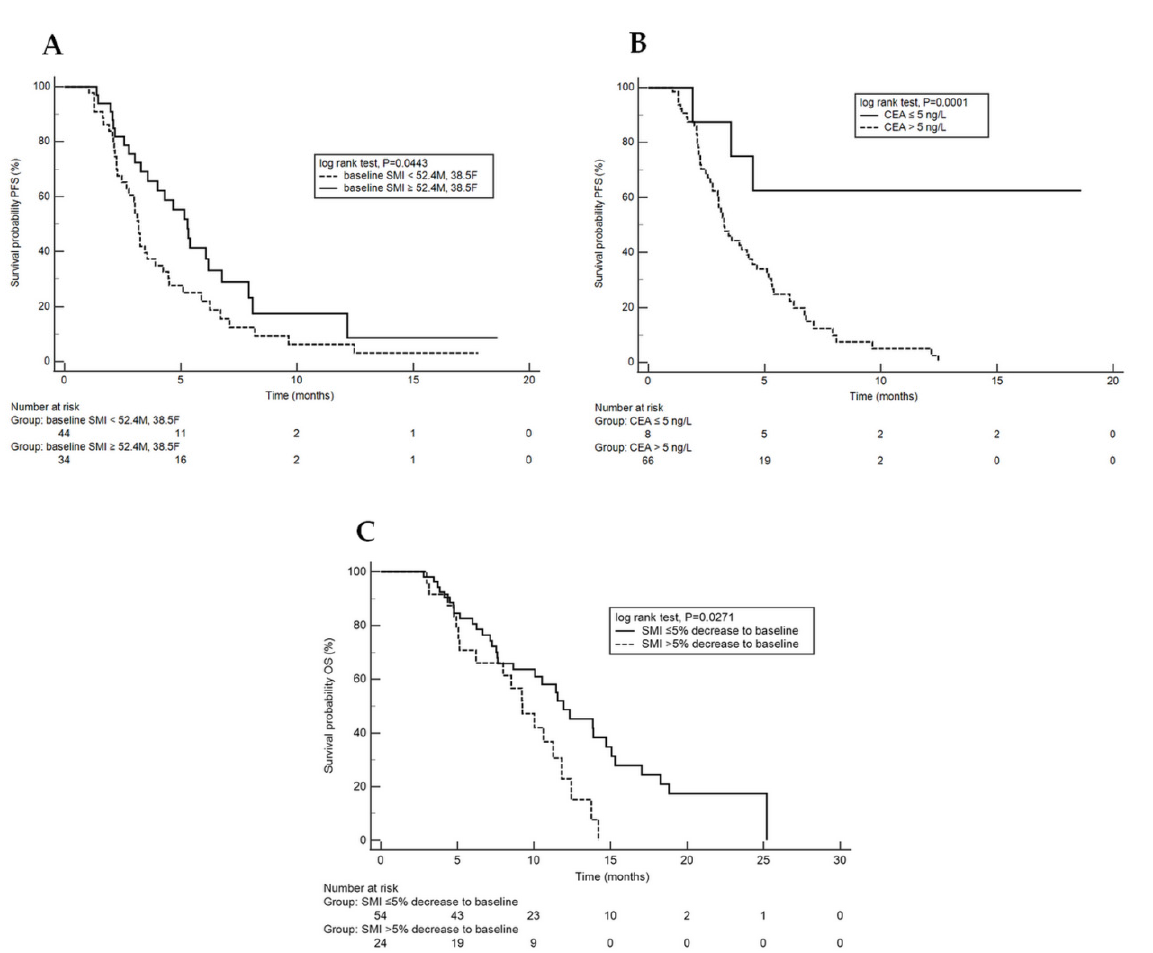
Figure 2. Kaplan–Meier curves showing ( A ) progression-free survival under trifluridine/tipiracil; ( B ) overall survival under trifluridine/tipiracil.